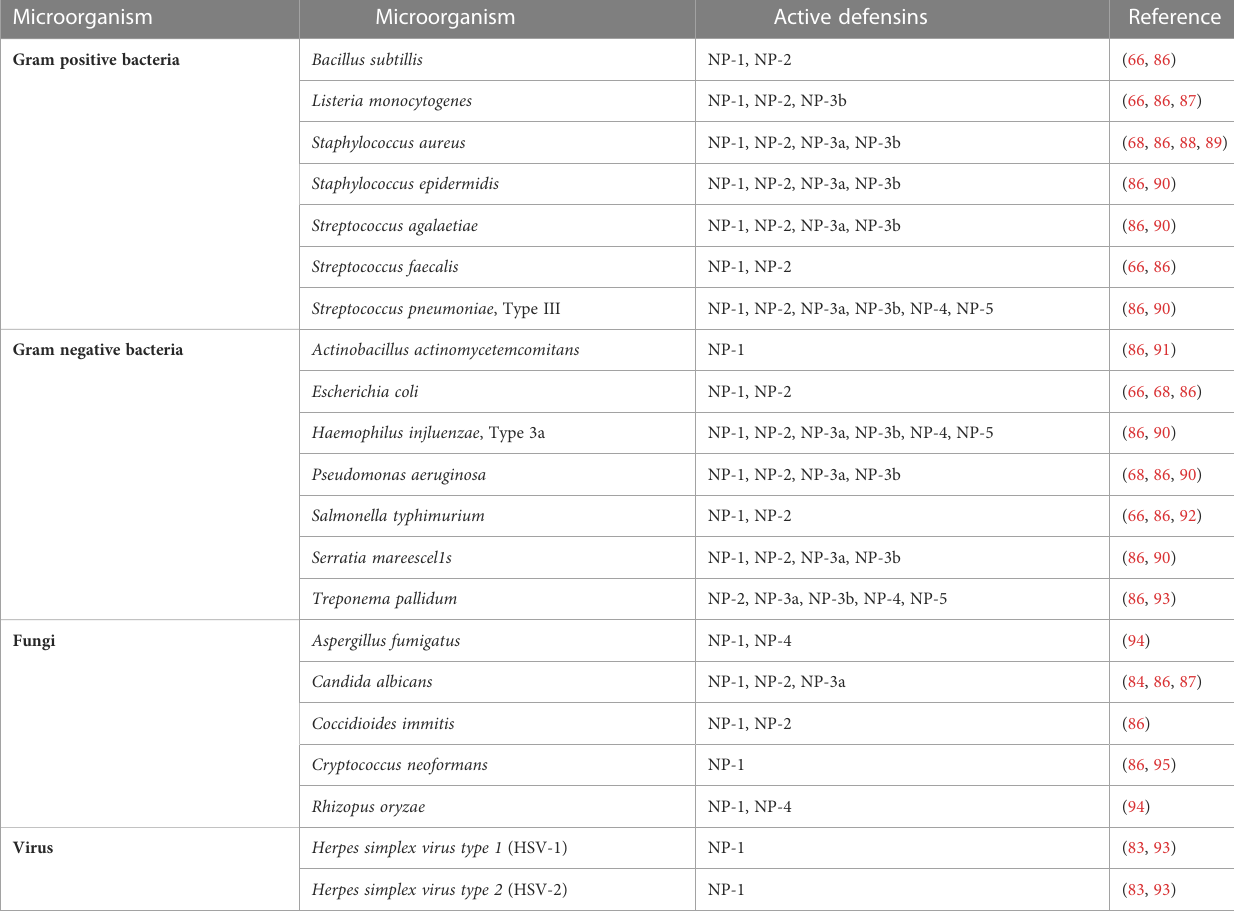
TABLE 2 Con fi rmed antibacterial, antifungal and antiviral effect of rabbit a -defensins.